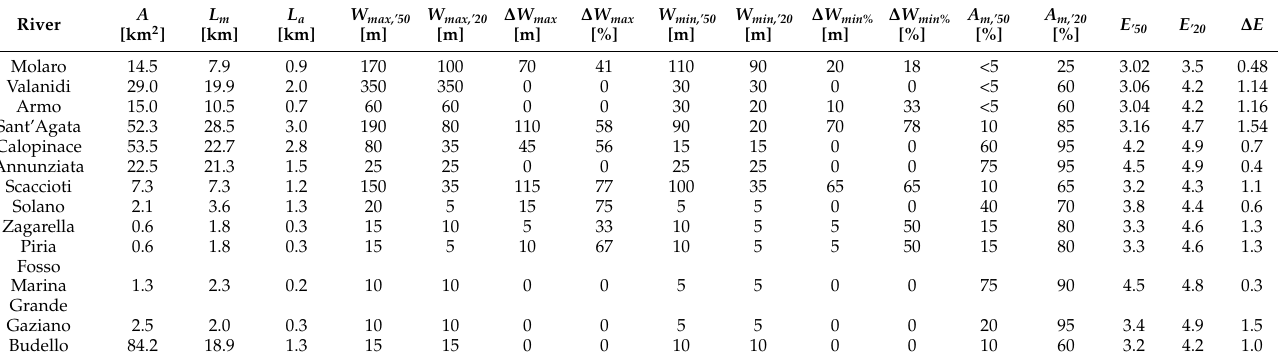
Table 1. The parameters analyzed for each river. Legend: A is the basin area; L m is the mainstream reach length; L a is the length of the river section where the effects of anthropogenic pressure occur; W max,’50 is the maximum river width in the 1950s; W max,’20 is the maximum river width in the 2020s; ∆ W max is the variation in the maximum river width between the 1950s and the 2020s; percentage variation of the maximum river width between the 1950s and the 2020s; W min,’50 is the minimum river width in the 1950s; W min,’20 is the minimum river width in the 2020s; ∆ W min is the variation in the minimum river width between the 1950s and the 2020s; ∆ W min% is the percentage variation of the minimum river width between the 1950s and the 2020s; A m’50 is the percentage of manmade area within 200 m of the river banks in the 1950s; A m’20 is the percentage of manmade area within 200 m of the river banks in the 2020s; E ’50 is the exposure class of the areas within 200 m of the river banks in the 1950s; E ’20 is the exposure class of the areas within 200 m of the river banks in the 2020s; and ∆ E is the percentage variation of the exposure class width between the 1950s and the